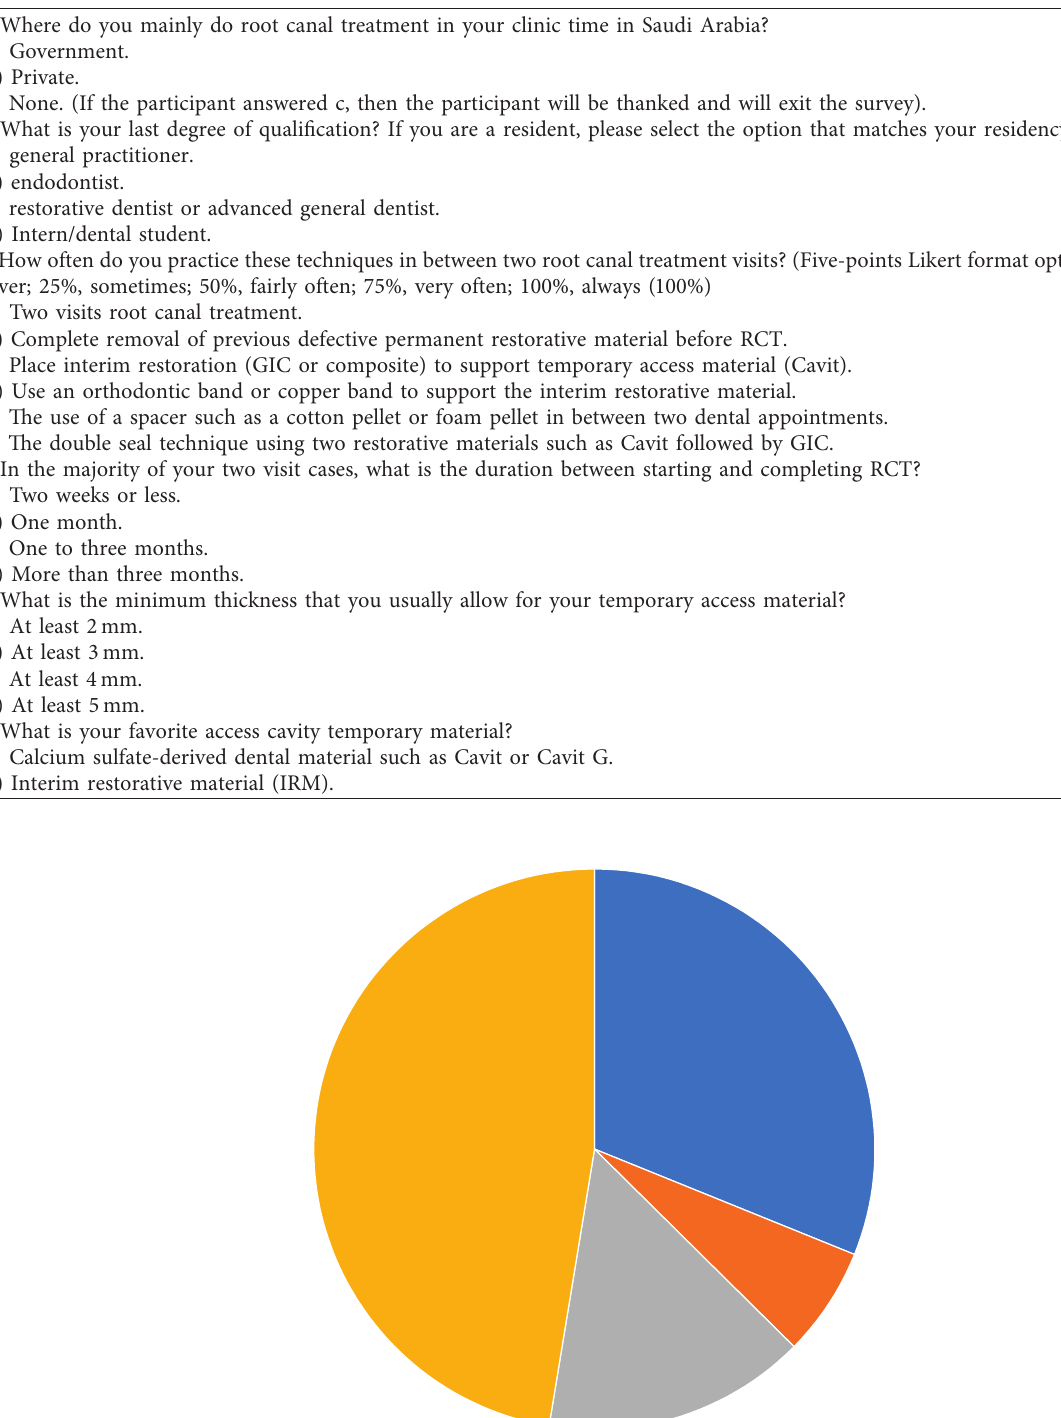
Table 1: The survey instrument.